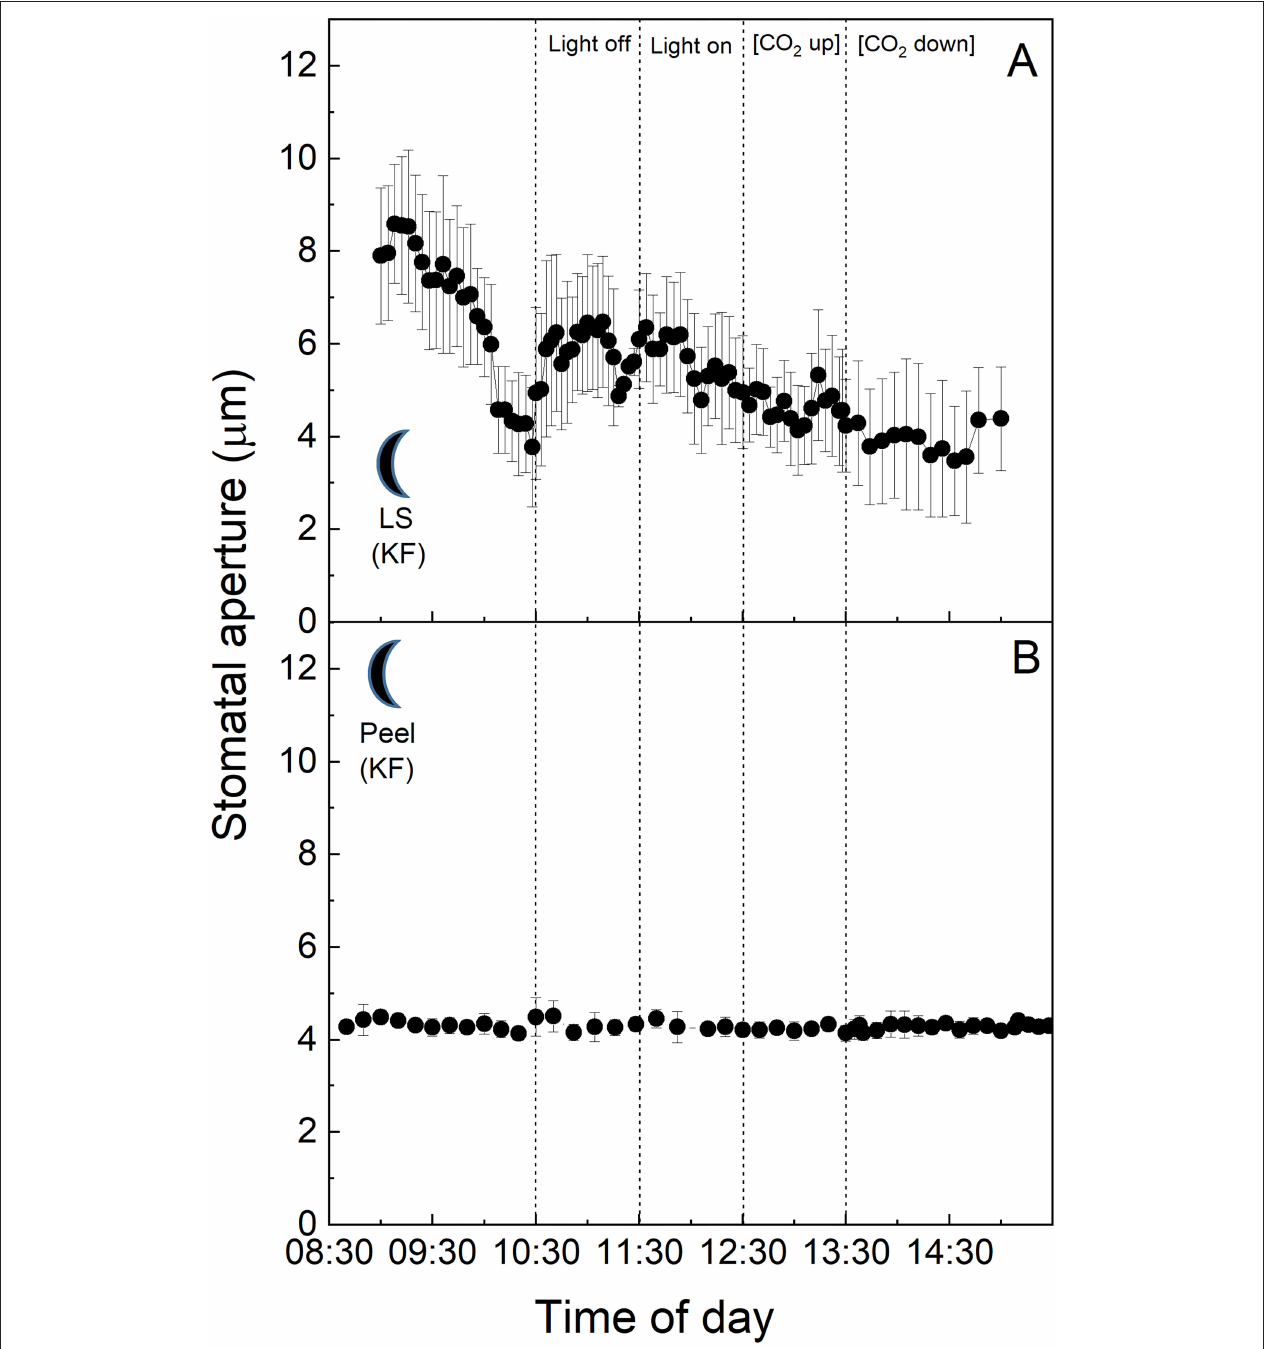
FIGURE 5 | (A) Kalanchoë fedschenkoi leaf segment from the “dark” growth chamber; (B) Abaxial isolated epidermis of Kalanchoë fedschenkoi leaf, from the “dark” growth chamber (light period 8:00 p.m. to 8:00a.m.). Light intensity was changed from photon flux density of 400 ± 10 µ mol m − 2 s − 1 to darkness, as indicated, and [CO 2 ] was changed from 120 to 650 µ mol mol − 1 , as indicated. The temperature of the chamber was maintained at 23 ± 1 ◦ C. The values are means of four repetitions ( ± SE). The moon symbol represents plants taken from the dark-grown